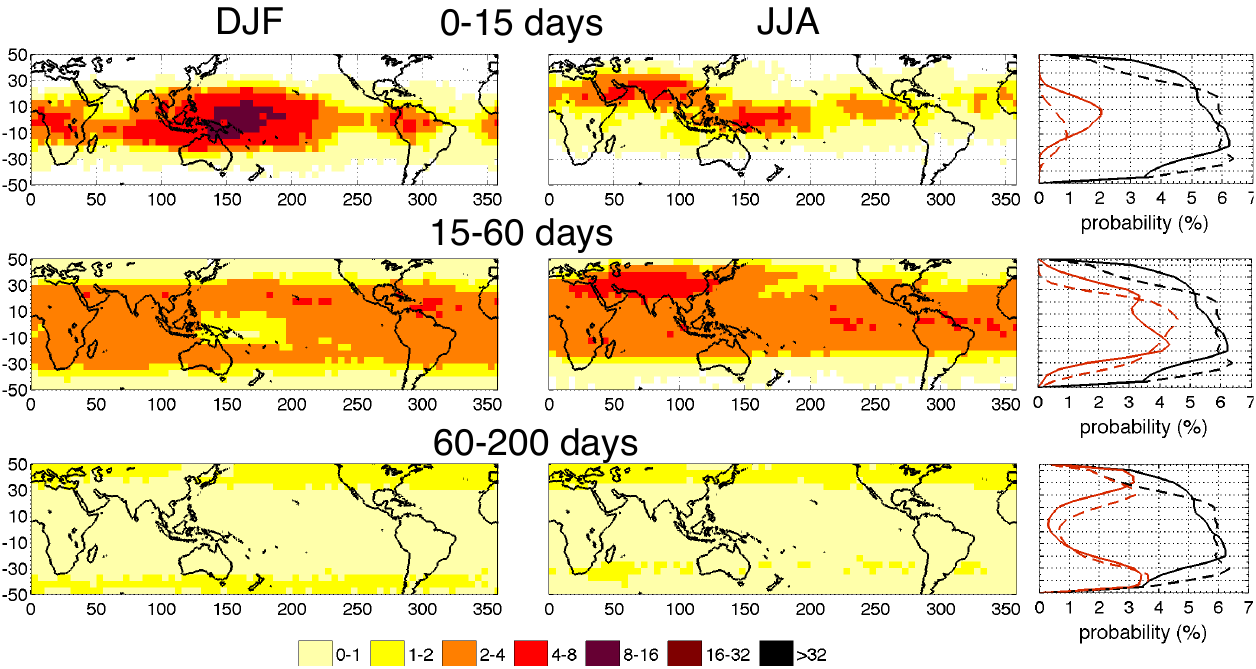
Fig. 11. Distribution, χ 100hPa , of the horizontal locations of trajectories that have intersected clouds within the previous 15 days (top), between 15 and 60 days (middle) and between 60 and 200 days (bottom) on the 100hPa launch surface. The distributions are calculated for trajectories detrained during the 2005 boreal winter (left) and boreal summer (middle) using the ALLSKY- 1T 0 trajectory ensemble. The distributions are binned in a 5 ◦ × 5 ◦ longitude/latitude grid and the histograms are calculated using a bin size of 5 degrees. The corresponding histograms showing the latitudinal position of CS-TTL trajectories detrained during boreal winter (solid) and summer (dashed) on the 100hPa surface, both the total (in black) and for different ranges of values for the transit-times, τ (in red).